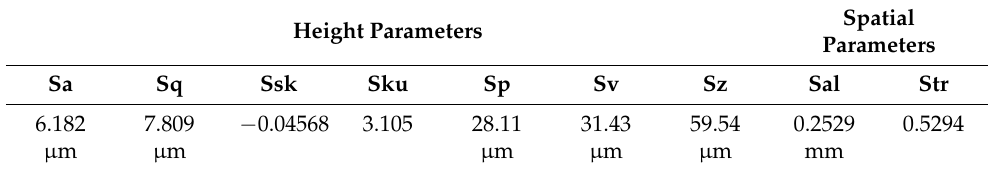
Table 4. Primary surface, spatial parameters, and functional parameters for the 0 ◦ slope surface.